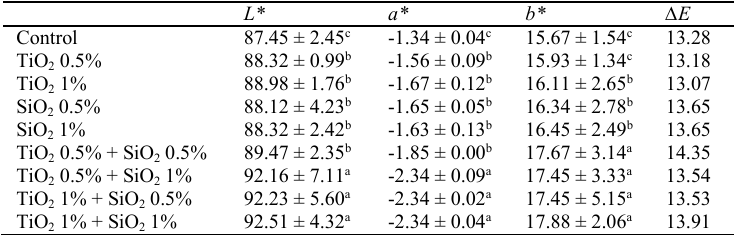
) and Silicon dioxide (SiO ) 2 2